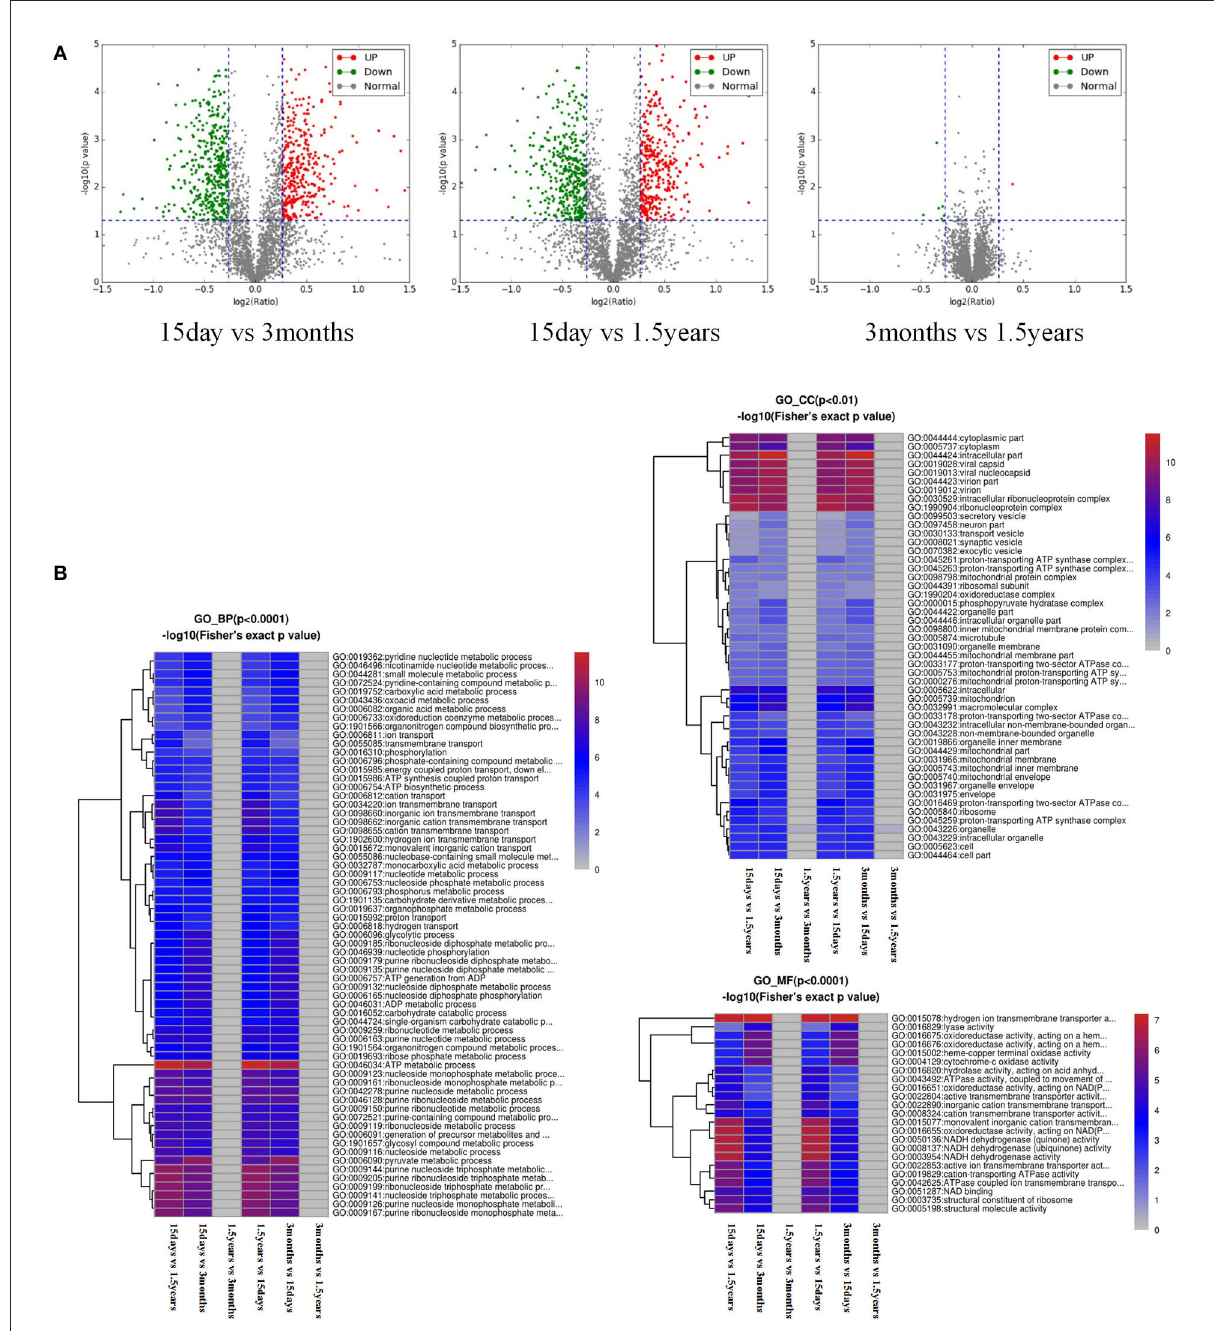
FIGURE1 Analysis of a difference in protein expression difference and a functional cluster. (A) Differentially expressed proteins and a visible volcano map screened out with the differential multiple of 1.2 and the differential p -value of 0.05. The abscisic coordinate in the figure is the multiple variation values of a difference between the two samples, for which log2 logization is performed. The ordinate is the statistical t -test p -value of the difference in protein expression, which is treated with –log10. The smaller the p -value is, the more significant the difference in expression is. Each dot represents a specific protein: green dots represent downregulated proteins, and red dots represent upregulated proteins. There were many different proteins between the 15-day age group and the other two age groups (3-month and 1.5-year age groups), whereas there were only a few different proteins between the 3-month and 1.5-year age groups. (B) Functional enrichment-based clustering for protein groups, and functional enrichment of the different proteins in the three biological processes, molecular functions, and cellular components. Reddish color indicates a significant difference; there were obvious differences between the 15-day age group and the other two age groups (3-month and 1.5-year age groups), whereas there was almost no difference between the 3-month and 1.5-year age